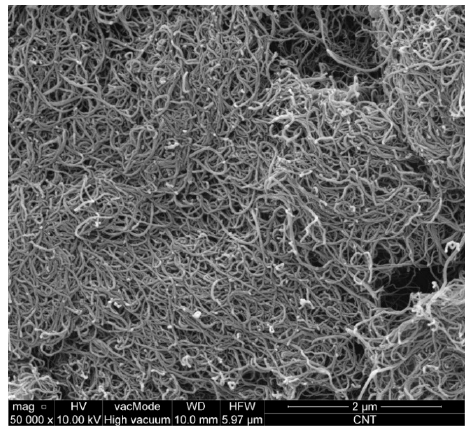
Figure 1. SEM image of MWCNTs used at 50,000× magnification; a visible tendency to agglomerate individual nanotubes into larger aggregates.